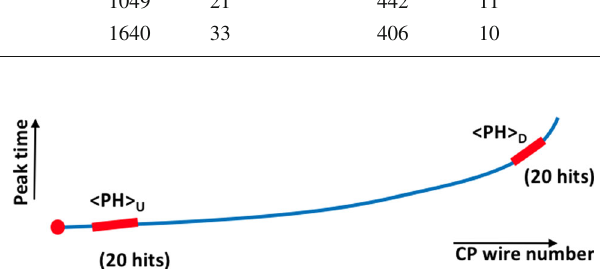
Fig. 3 GENIE expectations for true kinetic energy distributions for selected muons, pions, and protons. The kinetic energy thresholds associated with the 15 collection plane hit requirement for short tracks and the 75 cm length requirement for the long track are represented by dashed red lines Table 3 Final categories from Categories On-beam data the on-beam data, off-beam data, and MC default samples. Numbers are absolute event counts. The percentages correspond to the fraction of events in each category